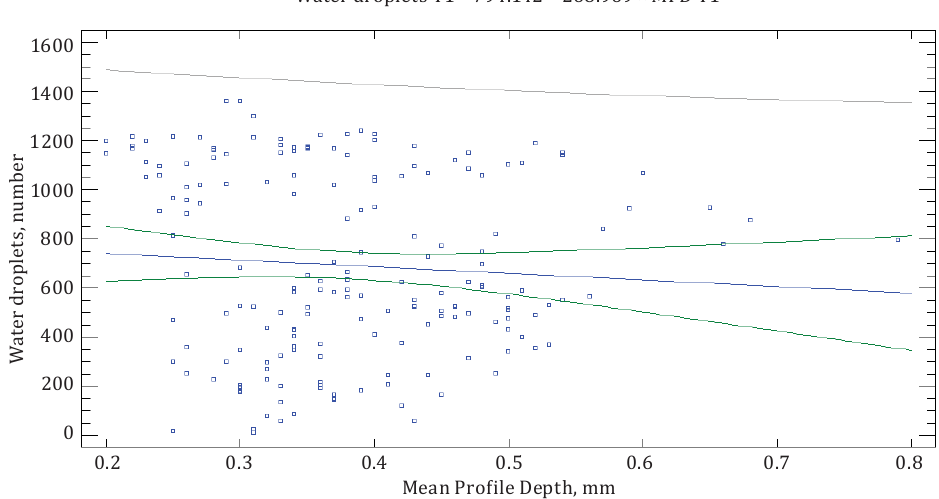
Plot of Fitted Model Water droplets T1 = 794.142 – 268.969 × MPD